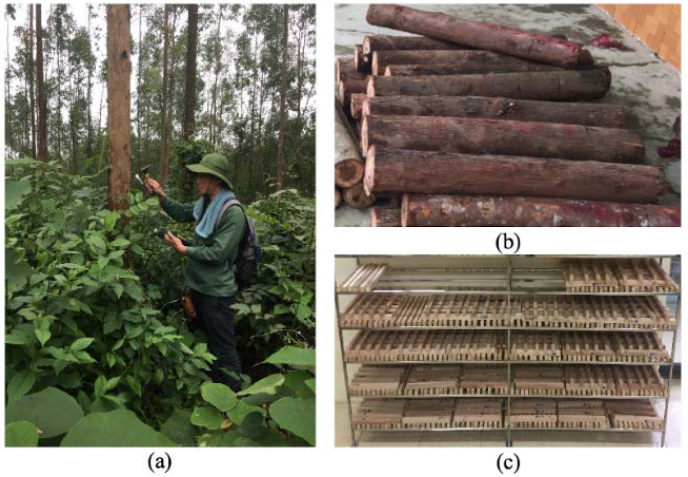
Figure 2. The experimental procedures: Measurement of acoustic velocity in standing trees ( a ), one meter logs from each sampled stem ( b ), and static bending samples ( c ).